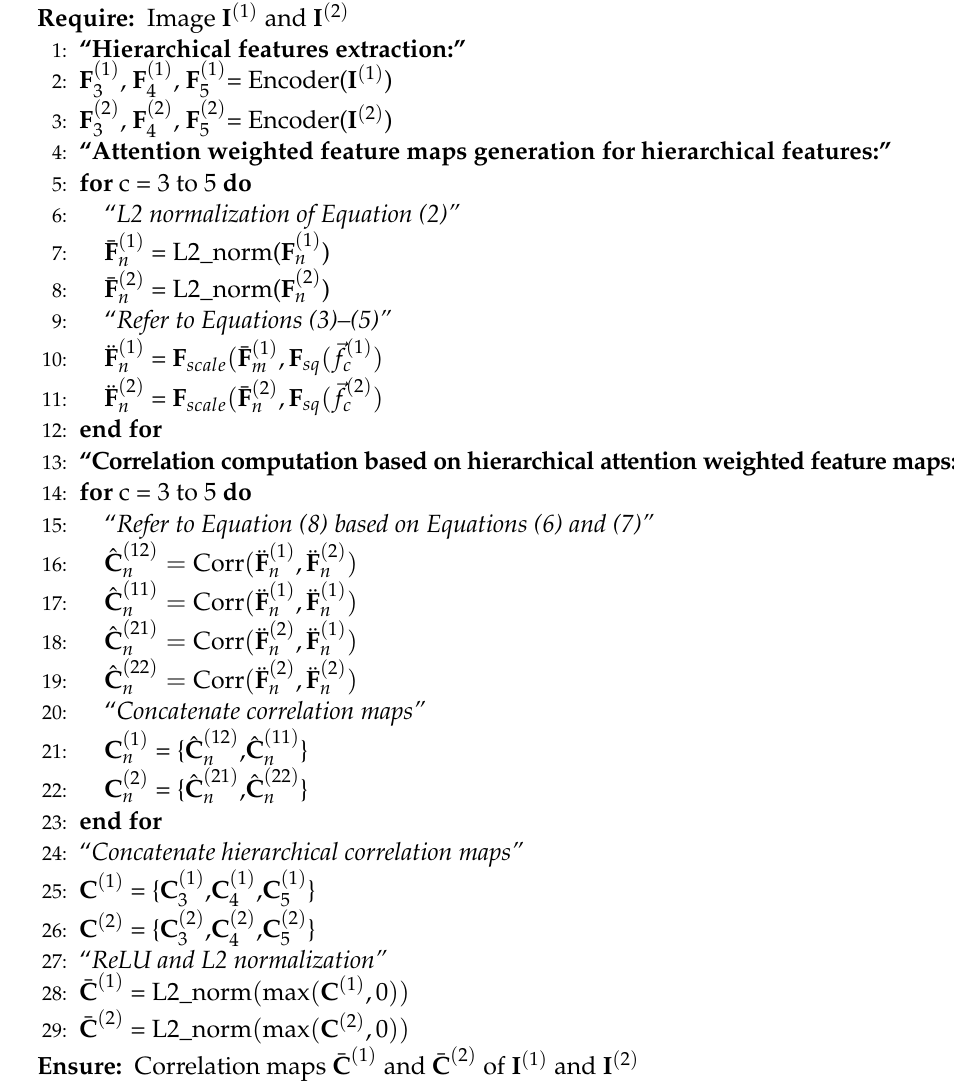
Algorithm 1: Scale-Adaptive Correlation